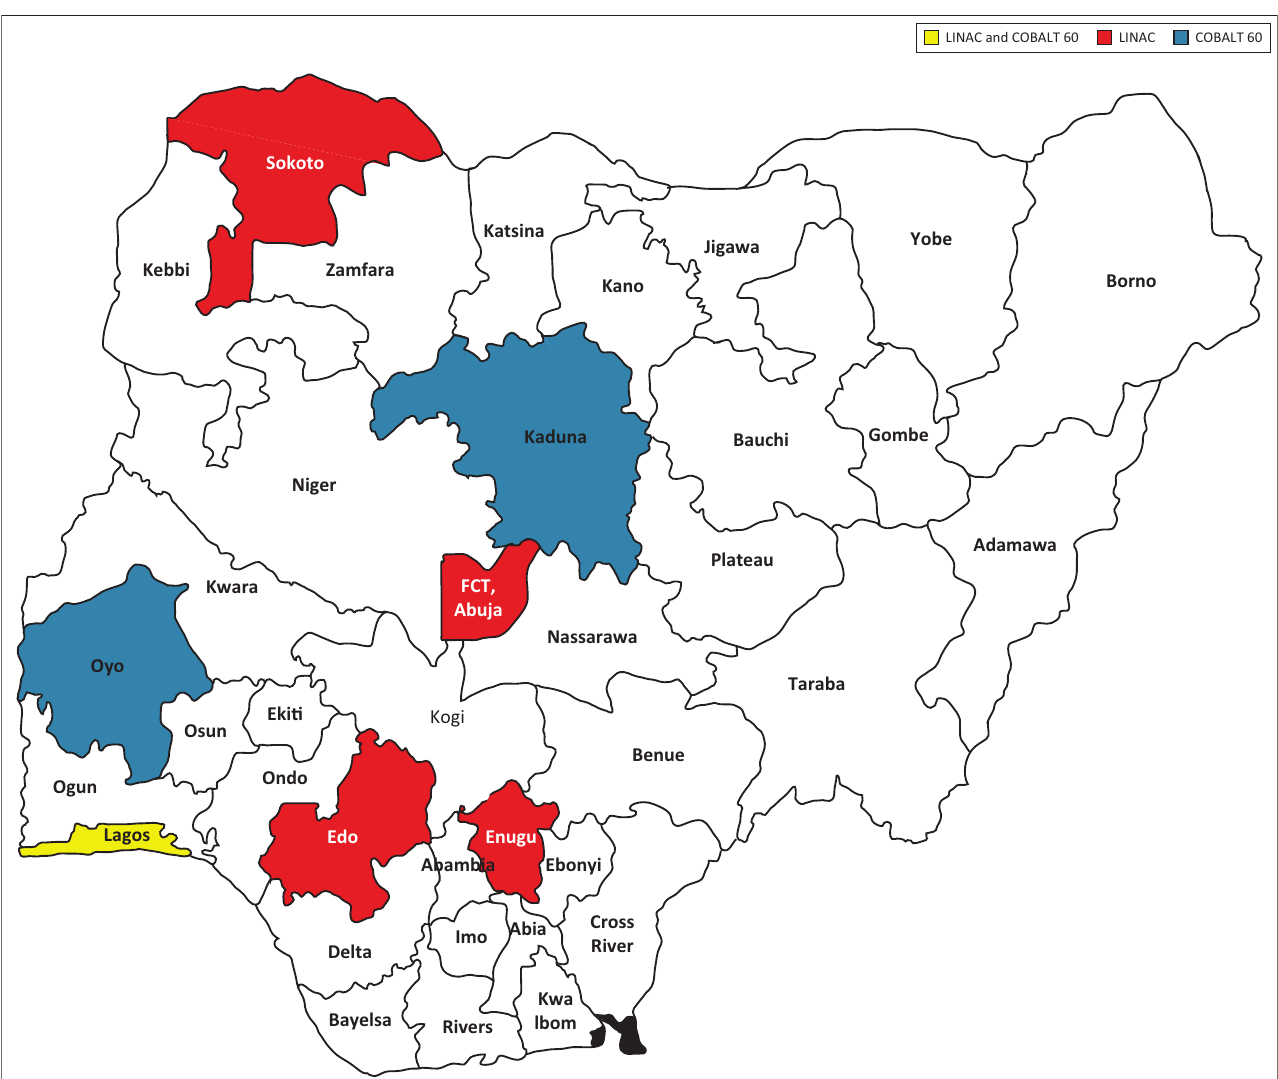
FIGURE 2-A1: Distribution of External Beam Radiotherapy machines in